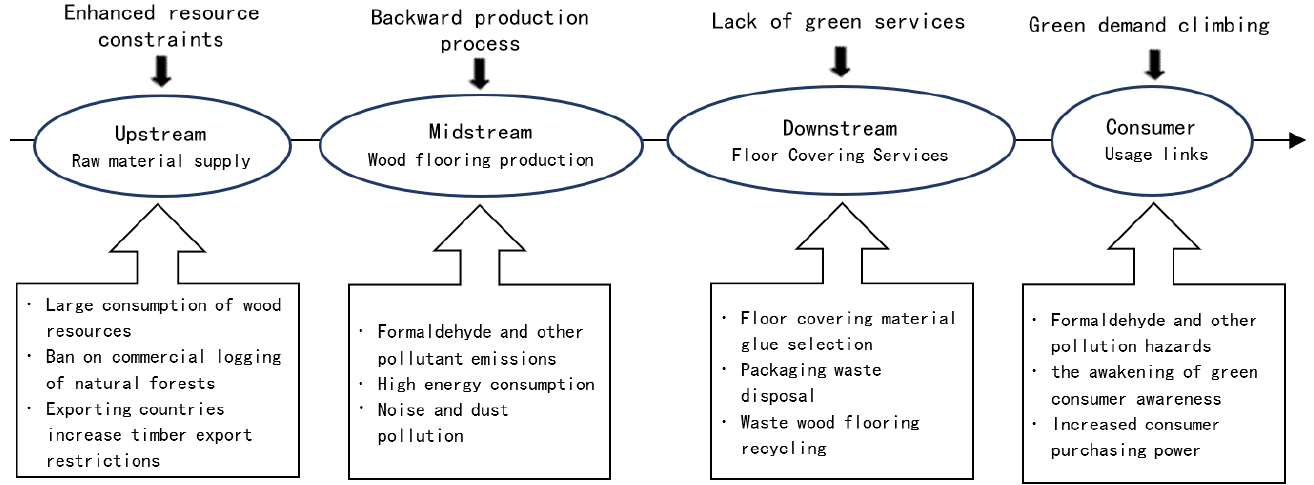
Figure 2. Environmental pressure from manufacturing to